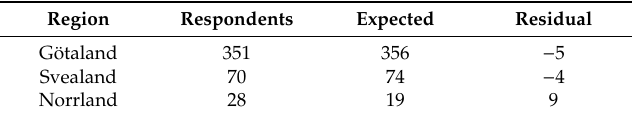
Table 4. Number of respondents according to region, compared to the expected number of responses if they had been randomly distributed. Information was missing for one